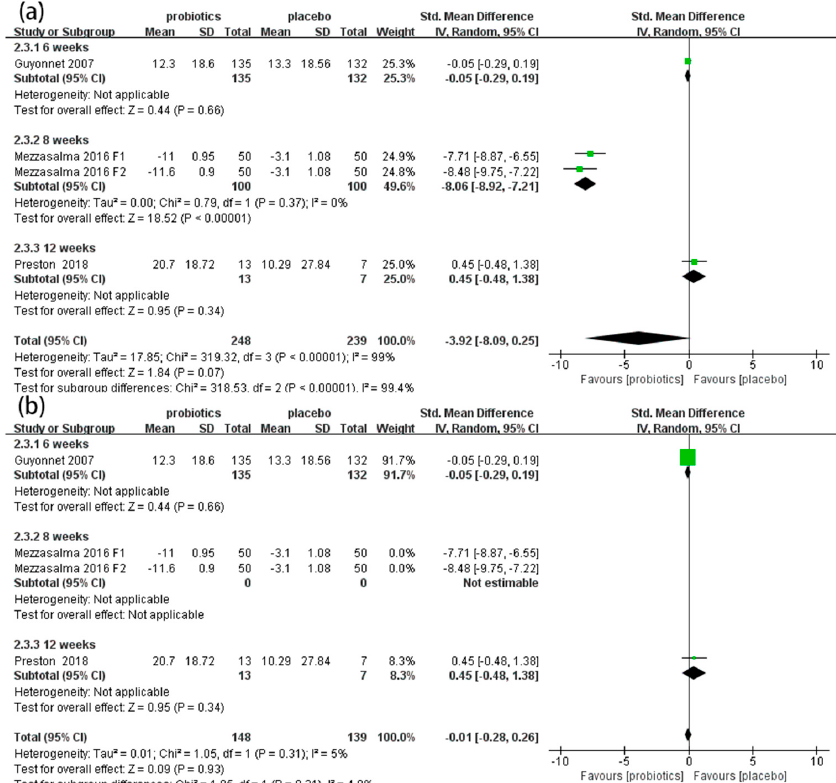
Figure 7. Effect of probiotics on quality of life (QoL) scores in IBS-C patients. ( a ) subgroup analysis for QoL scores; ( b ) sensitivity analysis for QoL scores. The green block represents the effect sizes of individual studies, black diamond block represents the combined effect size.